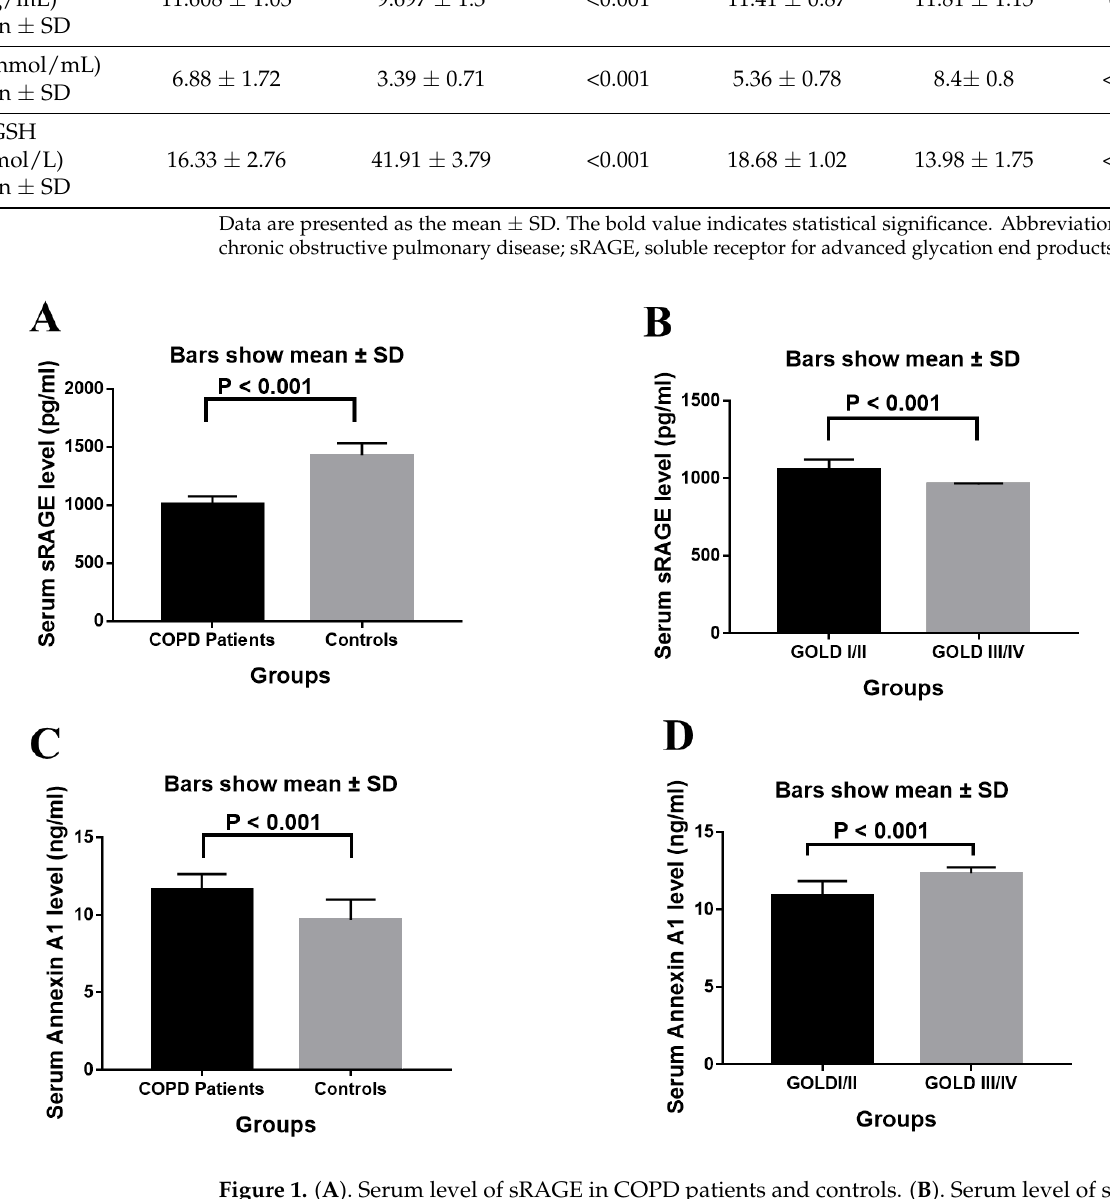
Figure 1. ( A ). Serum level of sRAGE in COPD patients and controls. ( B ). Serum level of sRAGE in COPD patients stratified according to disease severity (GOLD stages). ( C ). Serum level of annexin A1 in COPD patients and controls. ( D ). Serum level of annexin A1 in COPD patients and controls. Data are presented as mean ± SD. Abbreviations: COPD; chronic obstructive pulmonary disease, GOLD, Global Initiative for Chronic Obstructive Lung Disease, sRAGE, soluble receptor for advanced glycation end